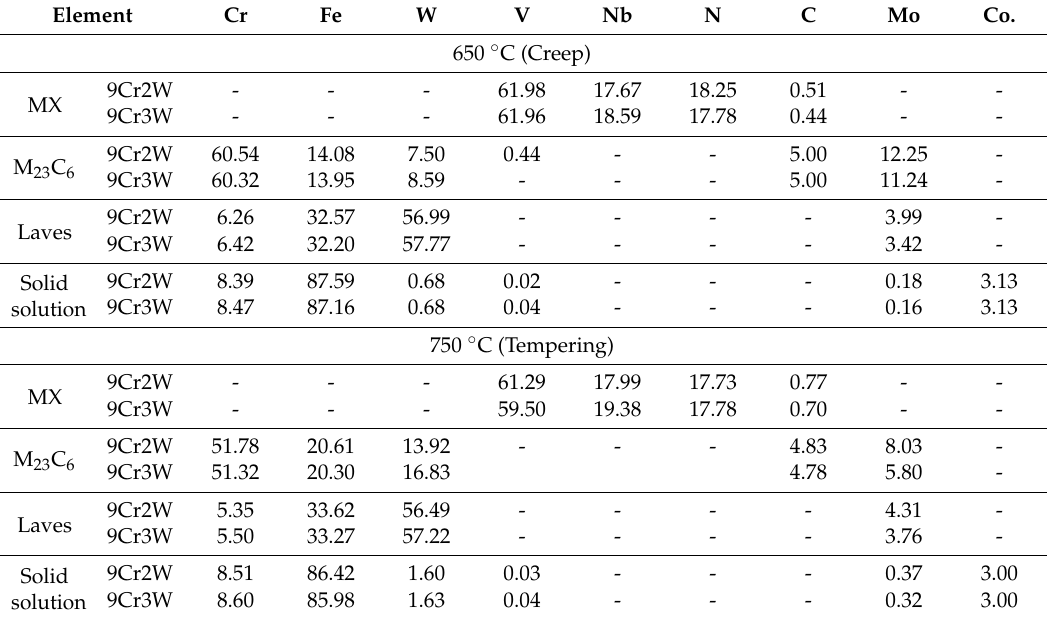
Table 3. Weight fraction of elements in the different phases in the steels studied at 650 and 750 ◦ C as calculated by Thermo-Calc.